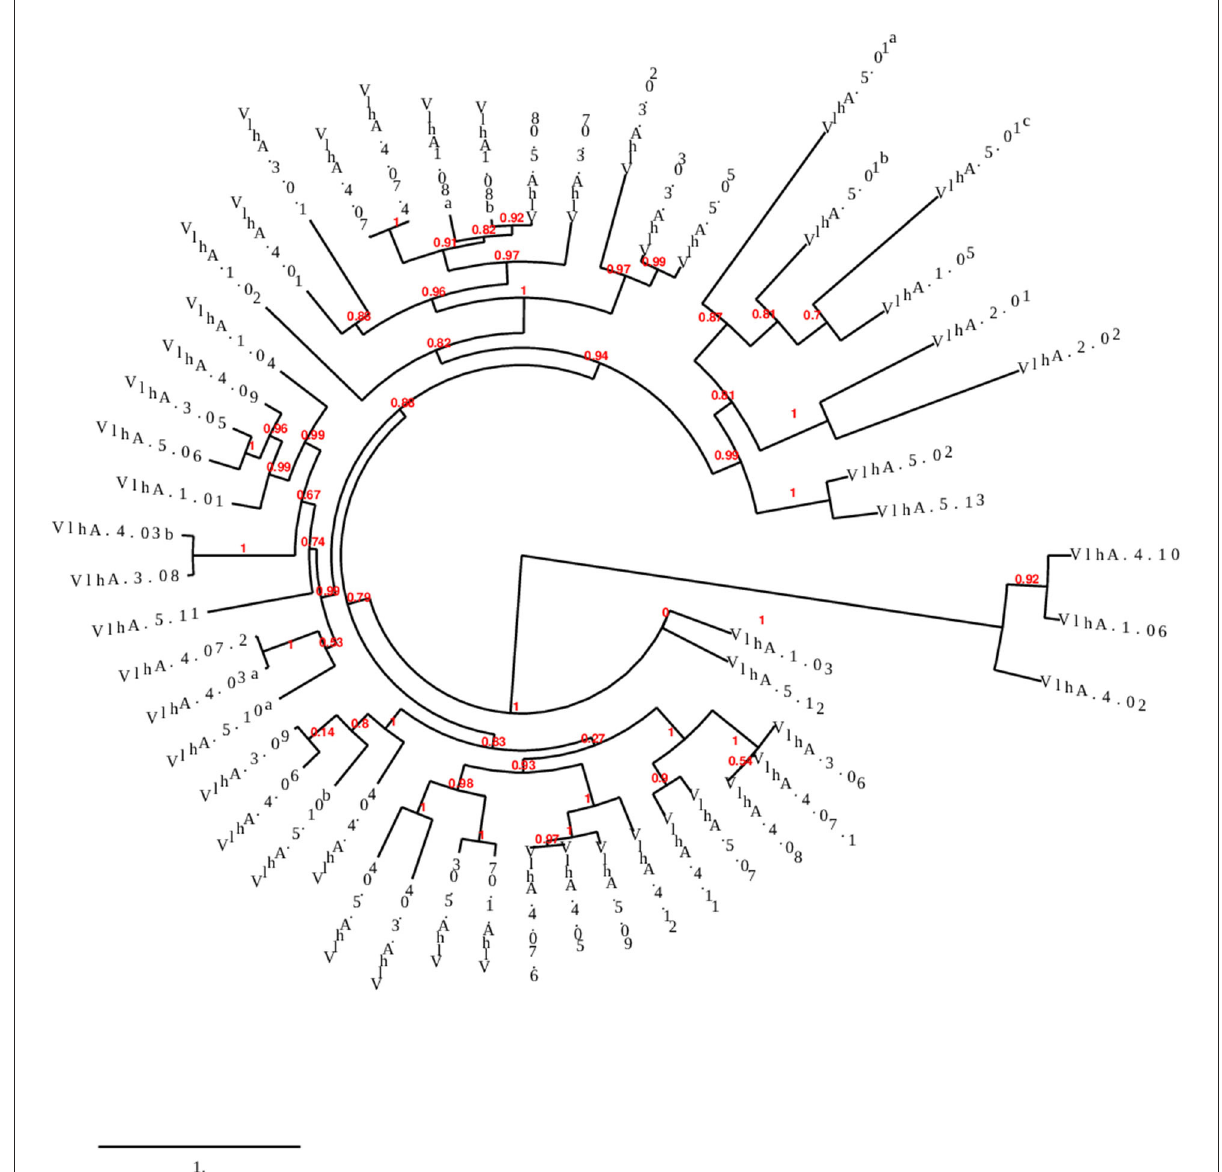
FIGURE2 Phylogenetic tree showing the evolutionary relationship of different M. gallisepticum vlhA proteins. The numbers indicate bootstrap percentages and the scale indicates the divergence time.